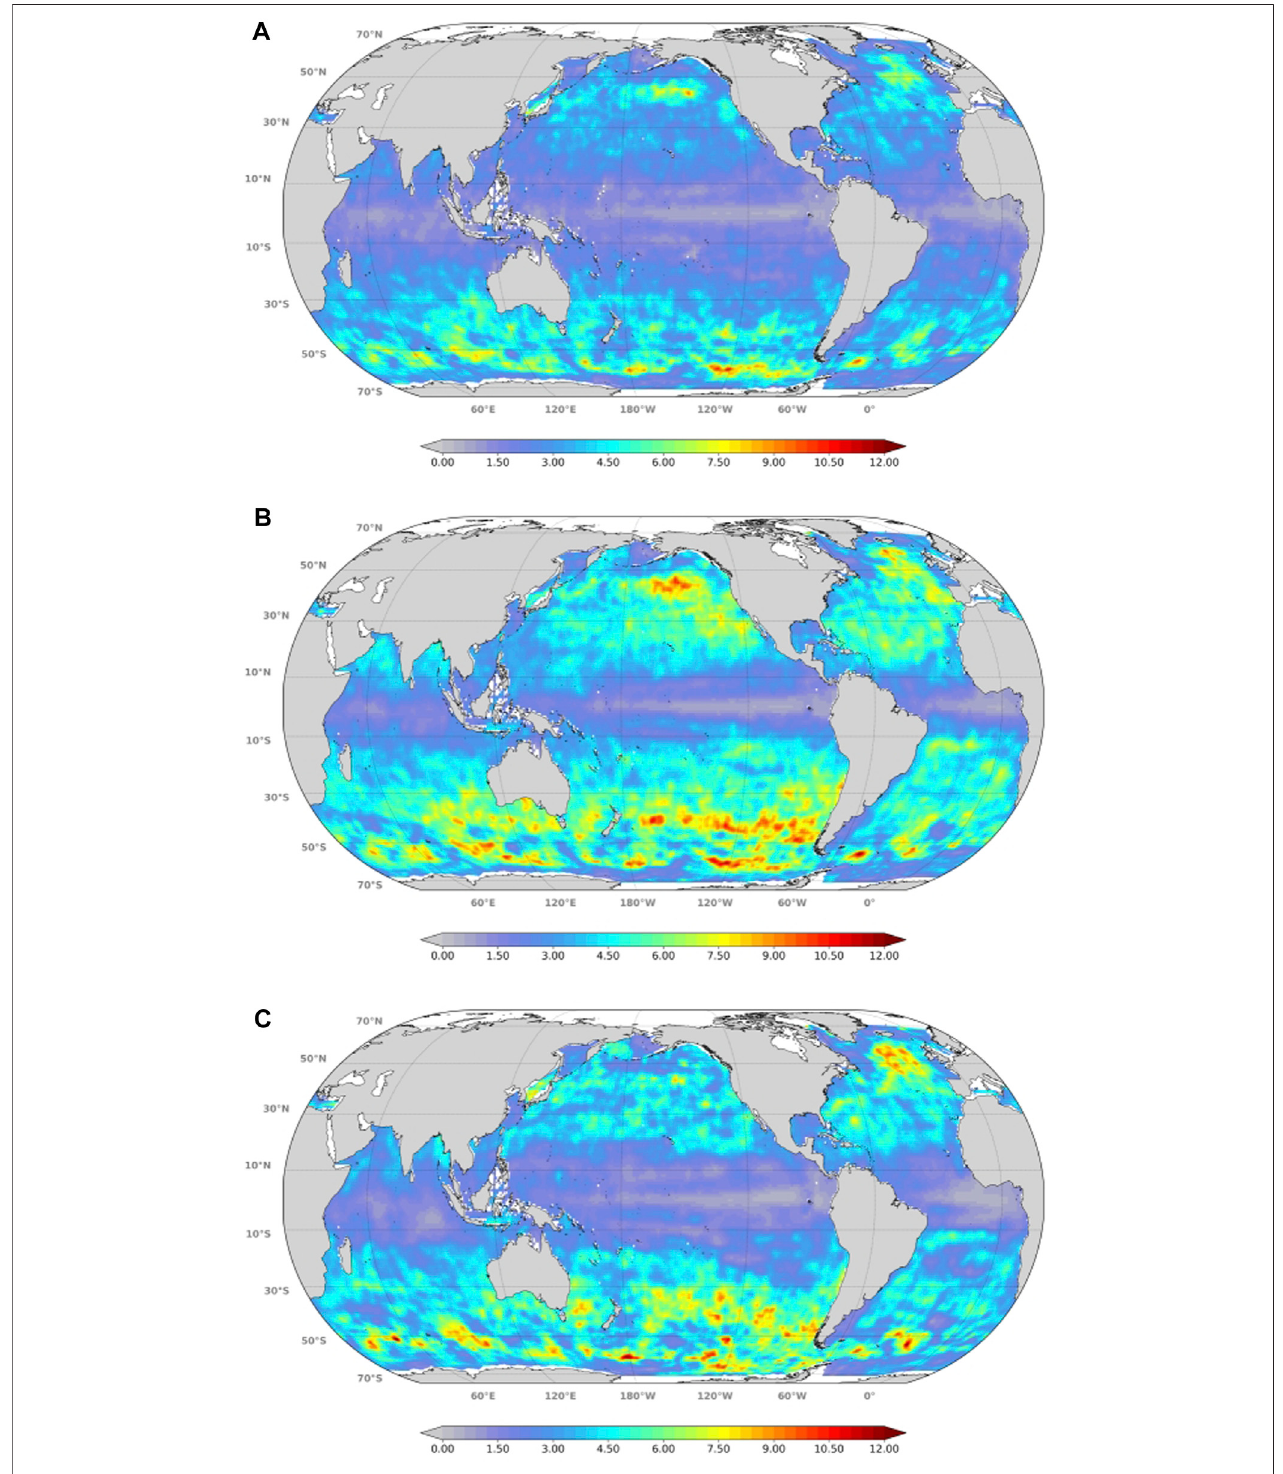
FIGURE11| Powerfractioninthemesoscale(50 – 250 km)bandnormalizedbythetotalpowerinthe20 – 980 kmbandforG4 (A) ,GLORYS12 (B) andF12 (C) SST in year 2013. Units are %.